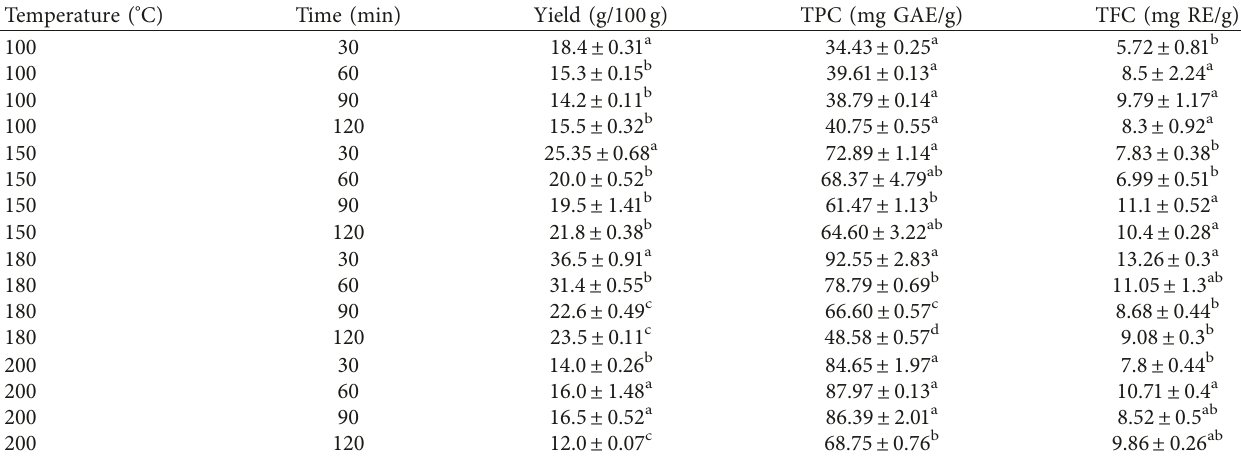
Table 1: Extraction yields, total phenolic content, and total flavonoid content of C. latifolia root extracts by subcritical water extraction (SWE) at different extraction